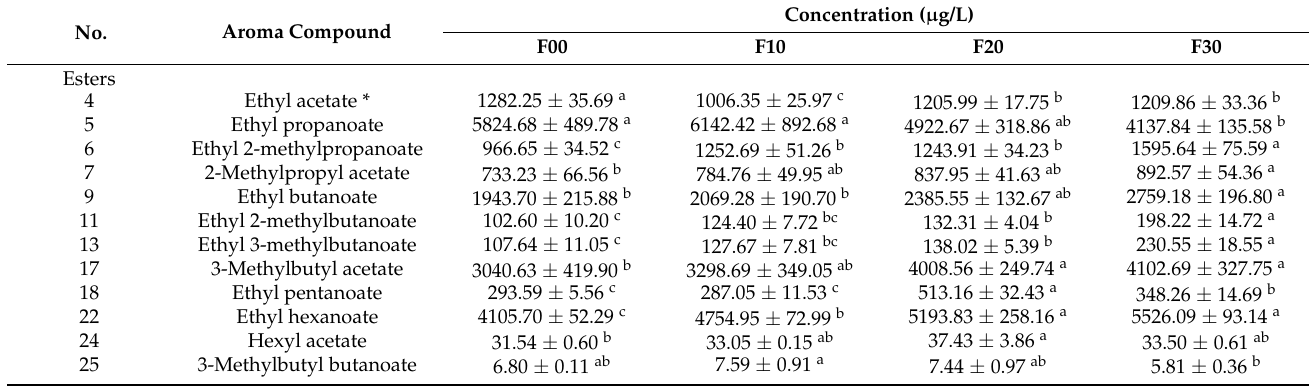
Table 2. Concentrations of aroma compounds in four different grades of